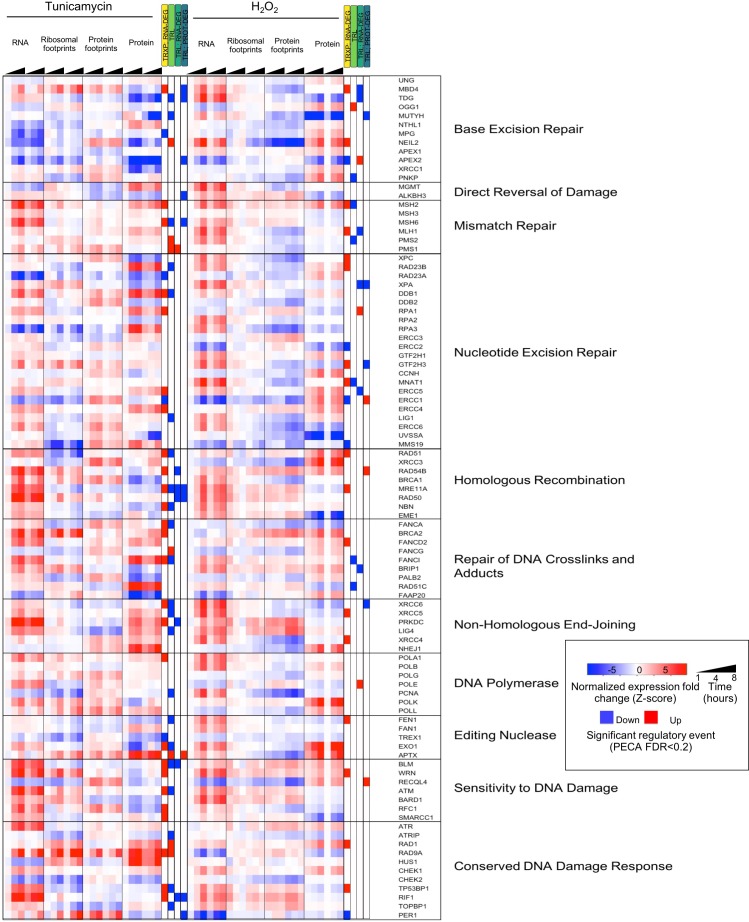
DNA repair pathways and their regulation during stress.The heatmap shows the extended data for DNA repair enzymes discussed in Figure 4A.